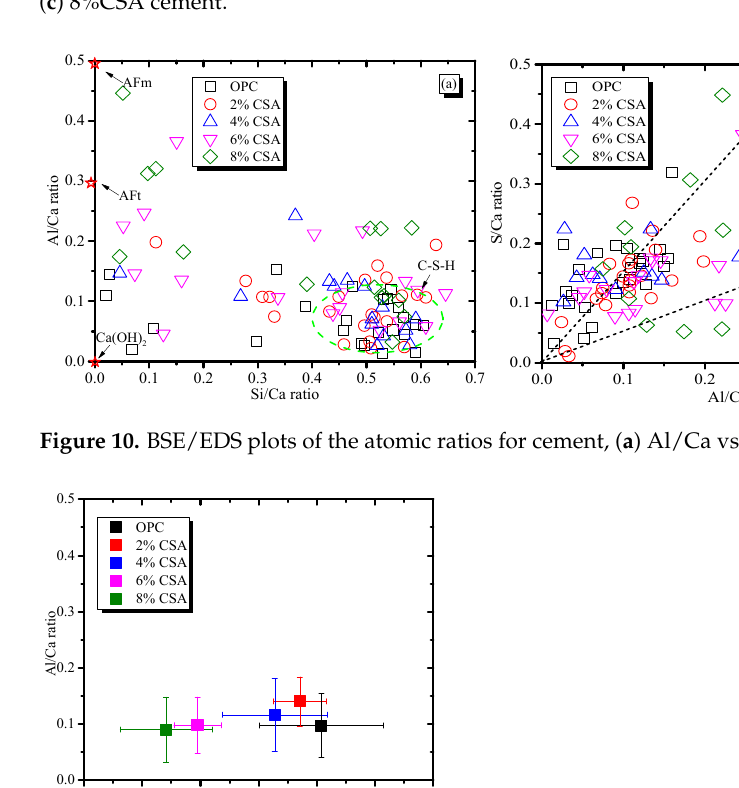
0.30 Figure 11. The average value of Al/Ca and Si/Ca in the C-S-H gels. Figure 11. The average value of Al/Ca and Si/Ca in the C-S-H gels. Figure 11. The average value of Al/Ca and Si/Ca in the C-S-H gels. Figure 11. The average value of Al/Ca and Si/Ca in the C-S-H